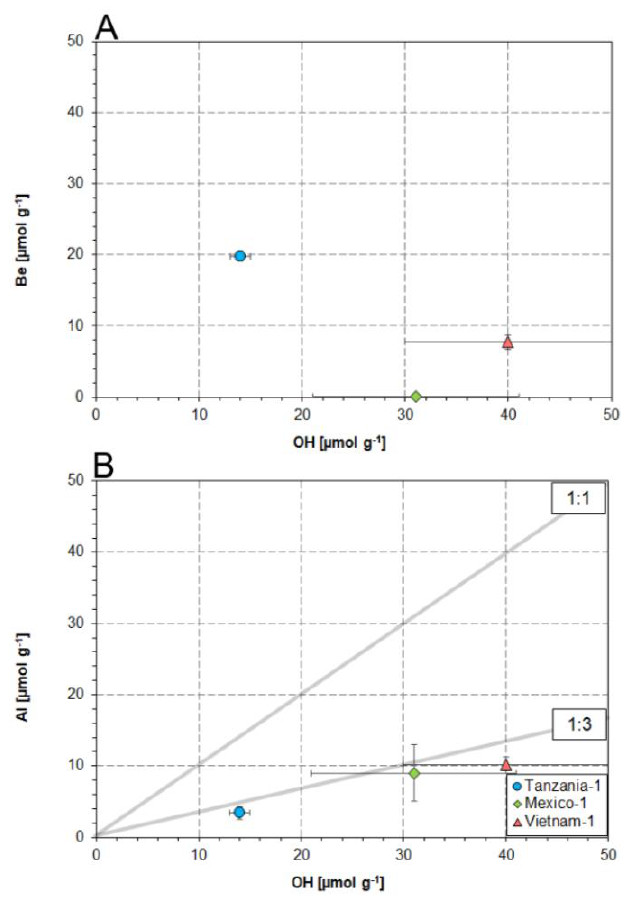
Figure 4. ( A ) Beryllium and OH correlate negatively, which suggests that incorporation into the danburite structure is not coupled. ( B ) However, Al shows a positive correlation with OH at a 1:3 ratio for all sampling locations, making a coupled incorporation of Al with OH